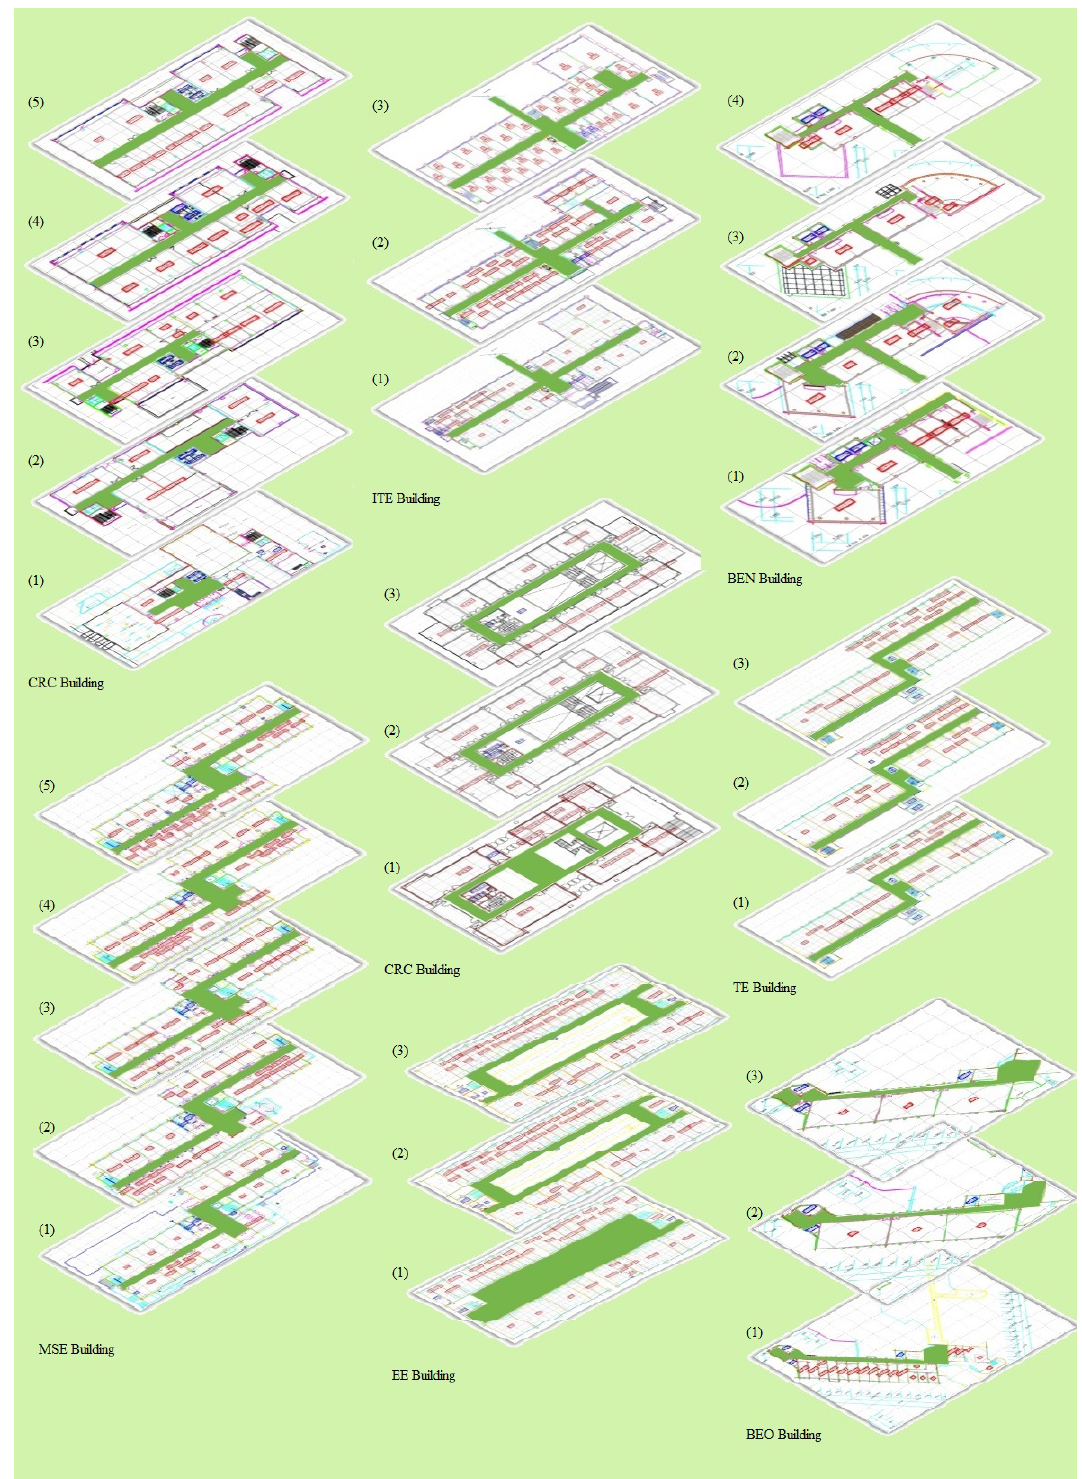
Figure 9. Indoor space of buildings used for the